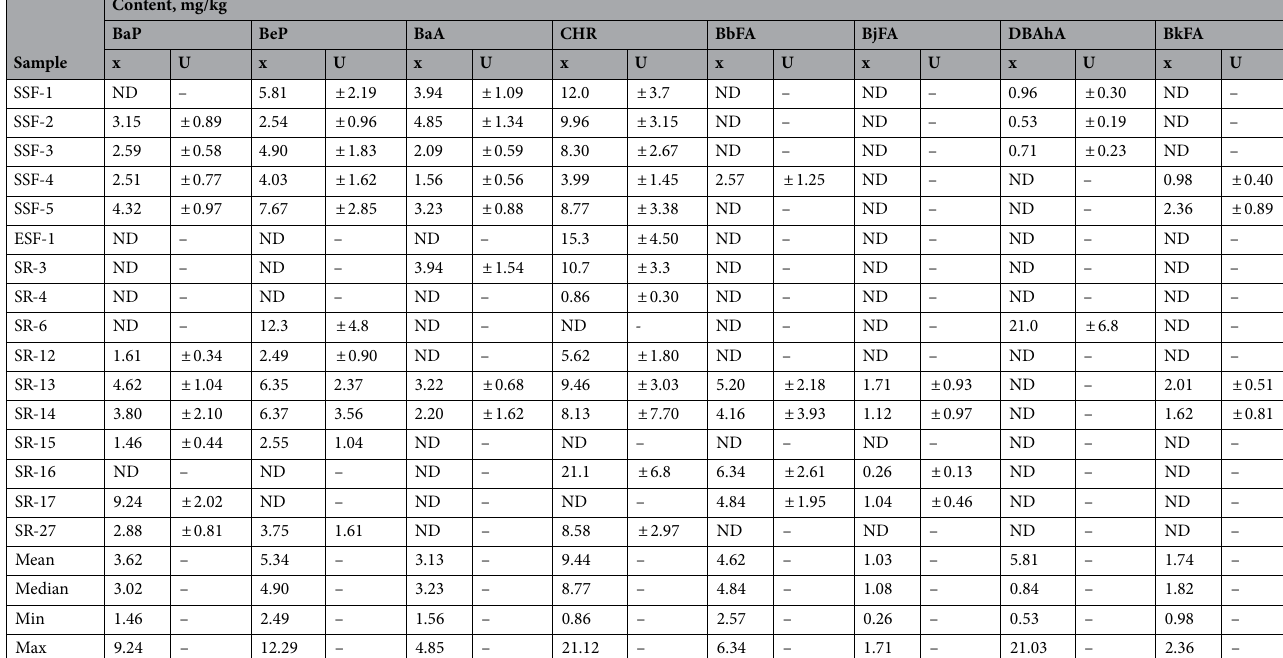
Table 4. The content of BaP, BeP, BaA, CHR, BbF, BjF, DBahA, BkF in rubber granules. ND not